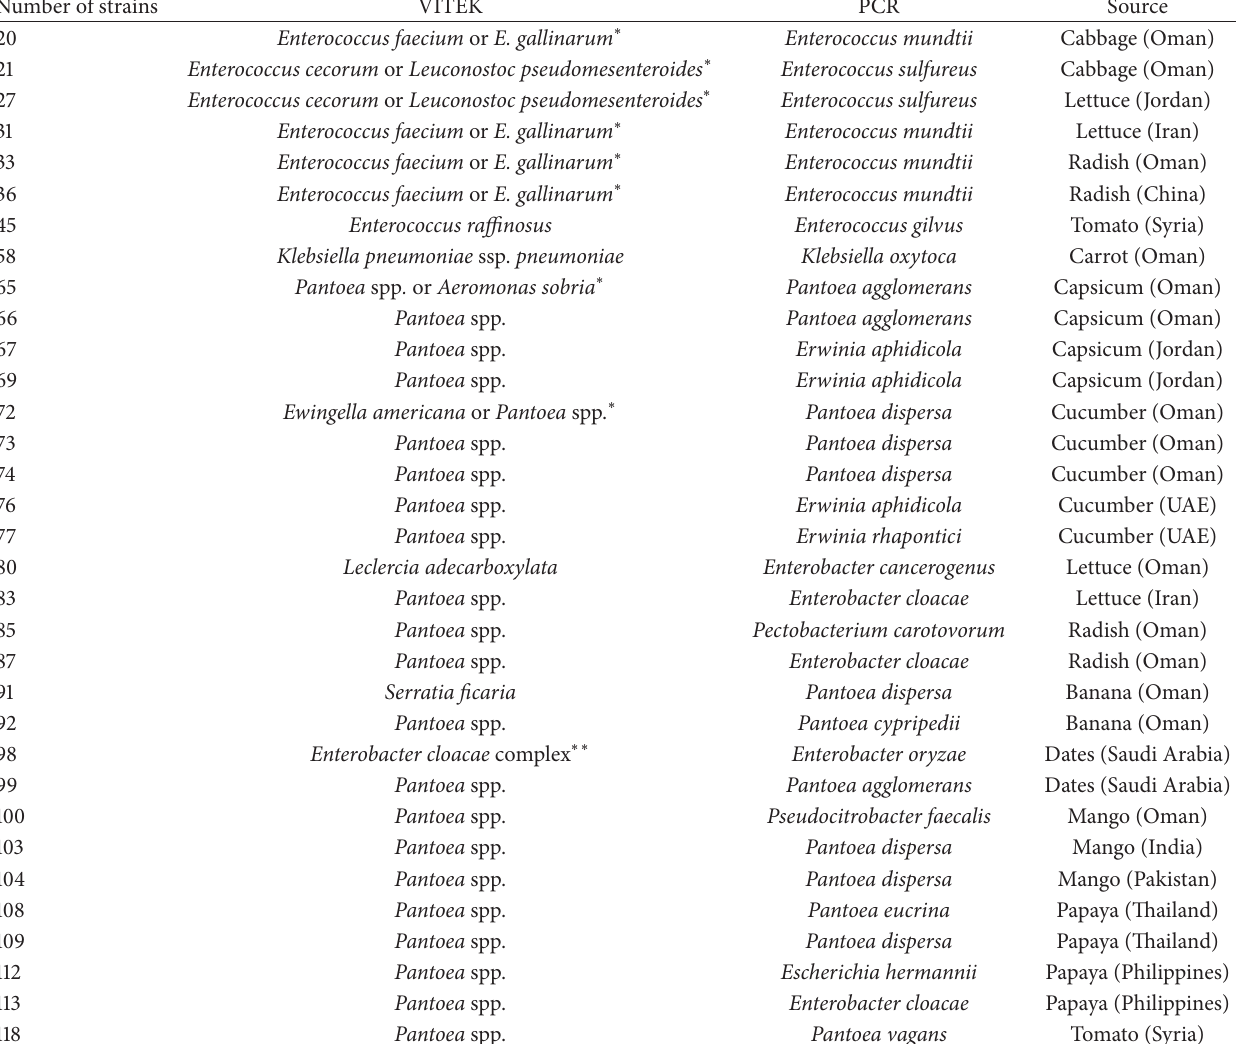
Table 3: Bacteria that were not similarly identified to species level by VITEK and PCR and their